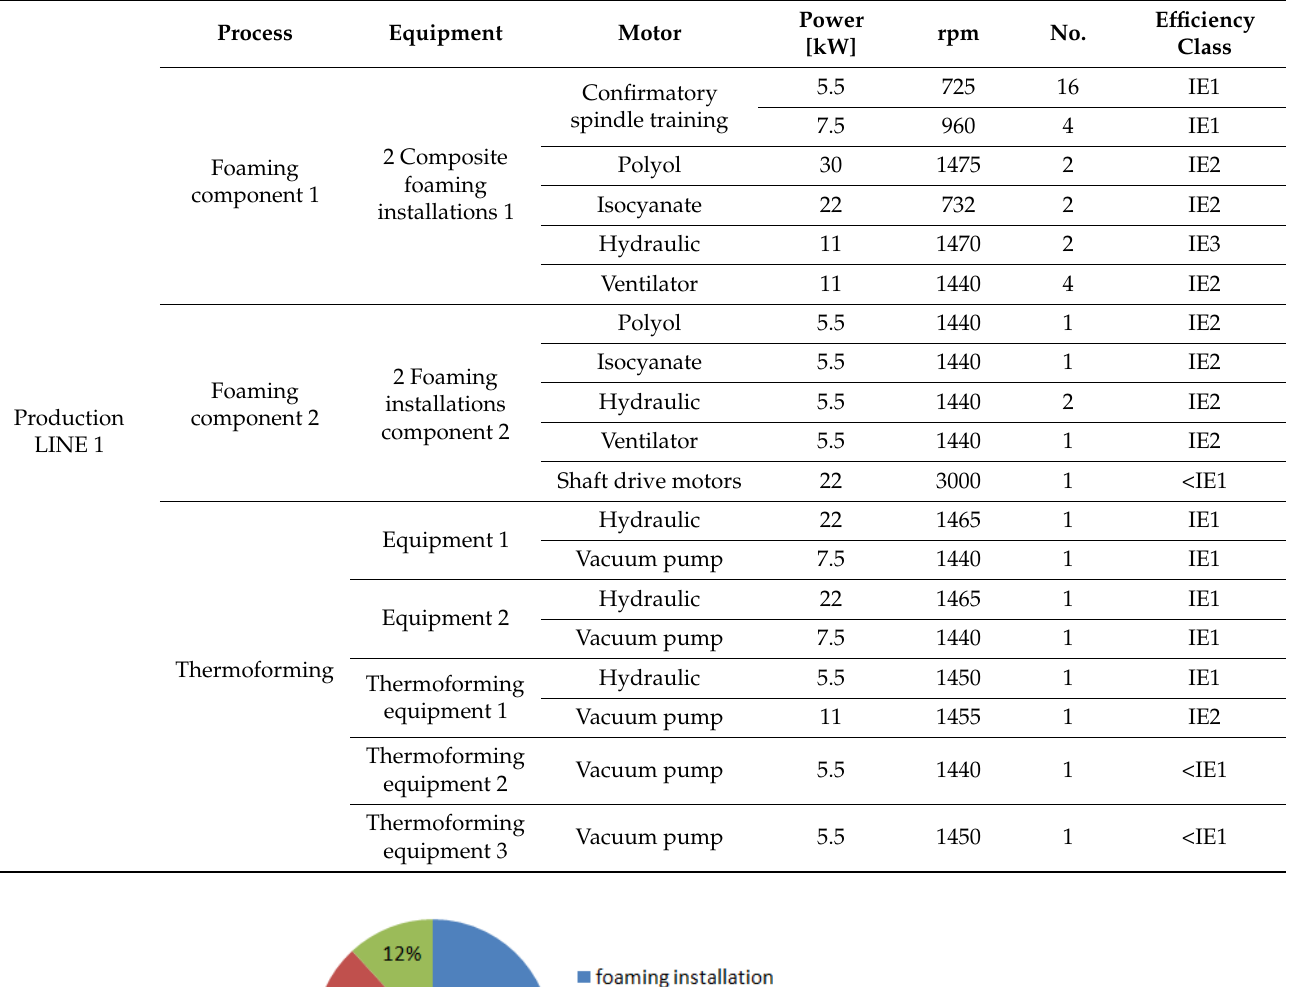
Table 5. Main consumers of energy of choice for Line 1.